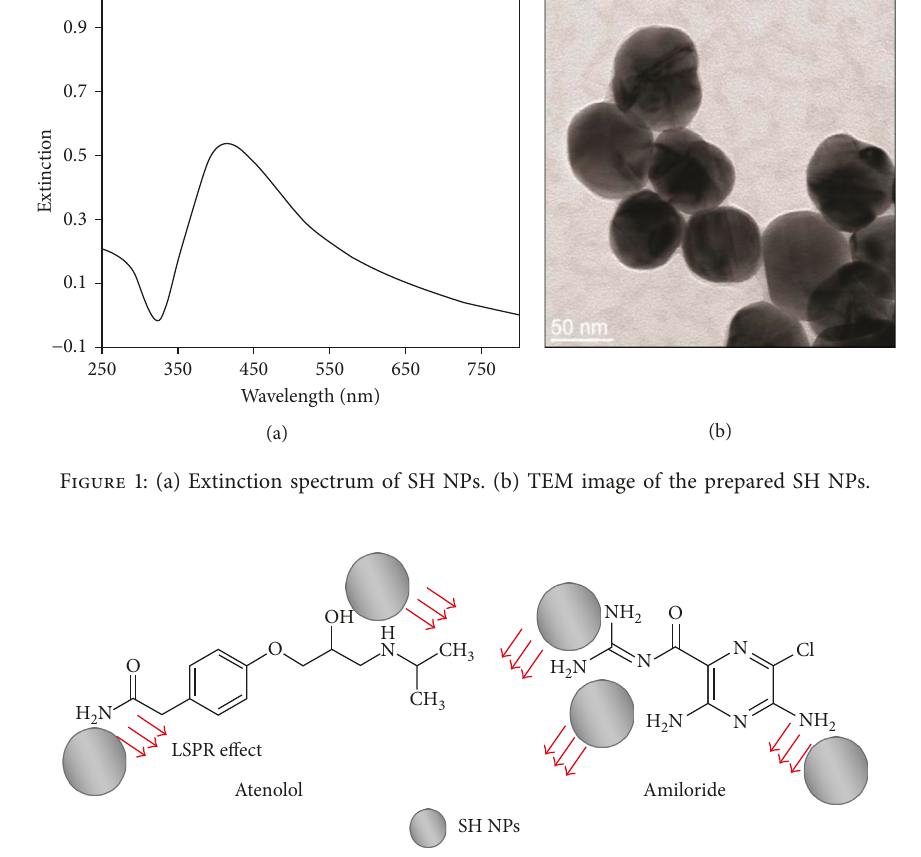
Figure 2: Proposed mechanism of the interaction of ATN and AML on SH NP